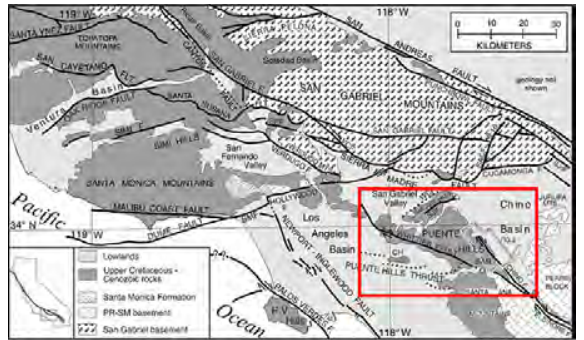
Figure 2. Geological overview of the Los Angeles Basin (Madden & Yeats, 2008)